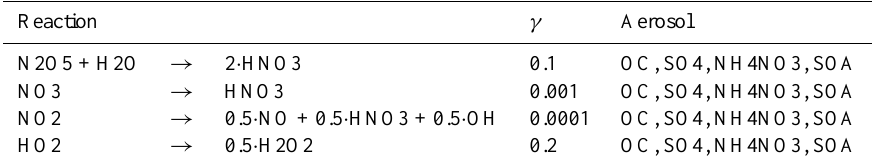
Table 5. Heterogeneous reactions included in MOZART-4, along with the reaction probability ( γ ) and the type of aerosols on which reactions occur.